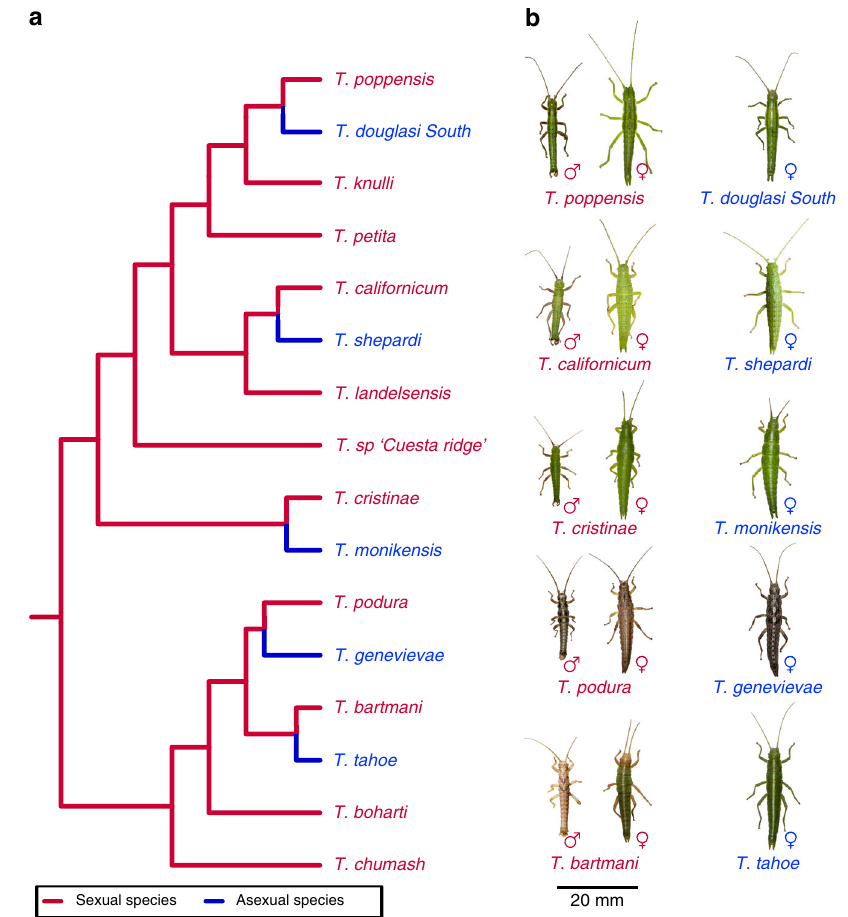
Fig. 1 Timema phylogeny and photographs. a Phylogeny of described Timema species (redrawn from Riesch et al. 36 ) with asexual species added from Schwander et al. 14 ). Sexually reproducing species are shown in red, independently derived asexual lineages in blue. Branches between sexual-asexual sister species indicate relative divergence time based on Jukes – Cantor corrected divergence from Bast et al. 16 . Note the oldest asexual lineage, T. genevievae , was previously estimated to be 1.5 My old 14 . b Photographs of the species used in this study scaled using median body lengths from their